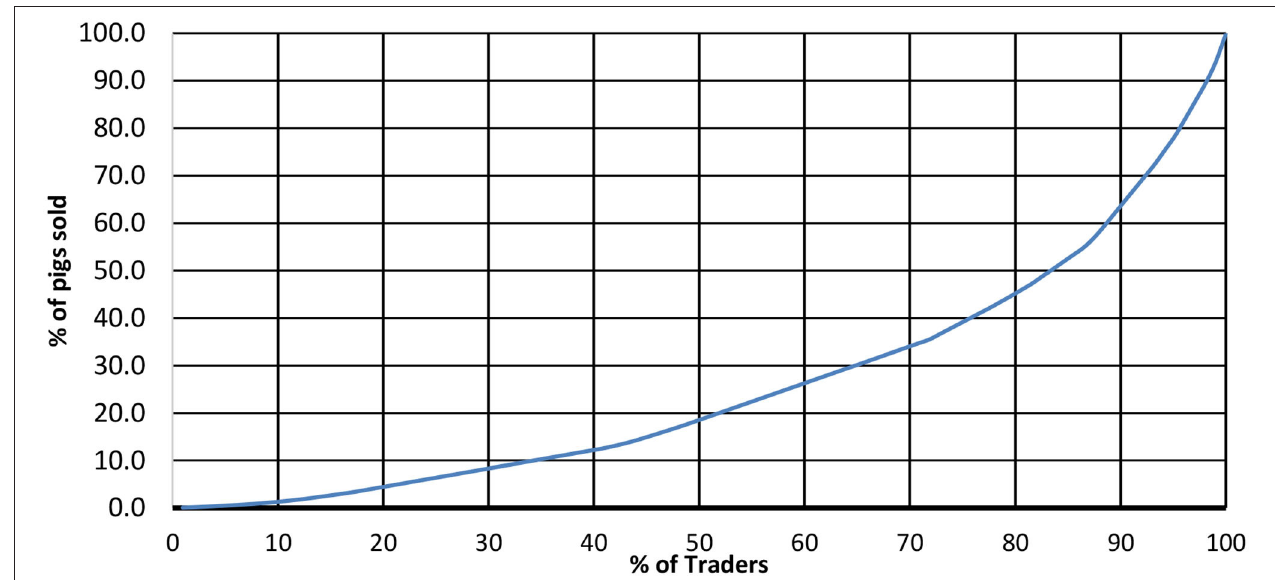
FIGURE 5 | Lorenz curve showing the proportion of supply to different proportion of traders within the less integrated abattoir